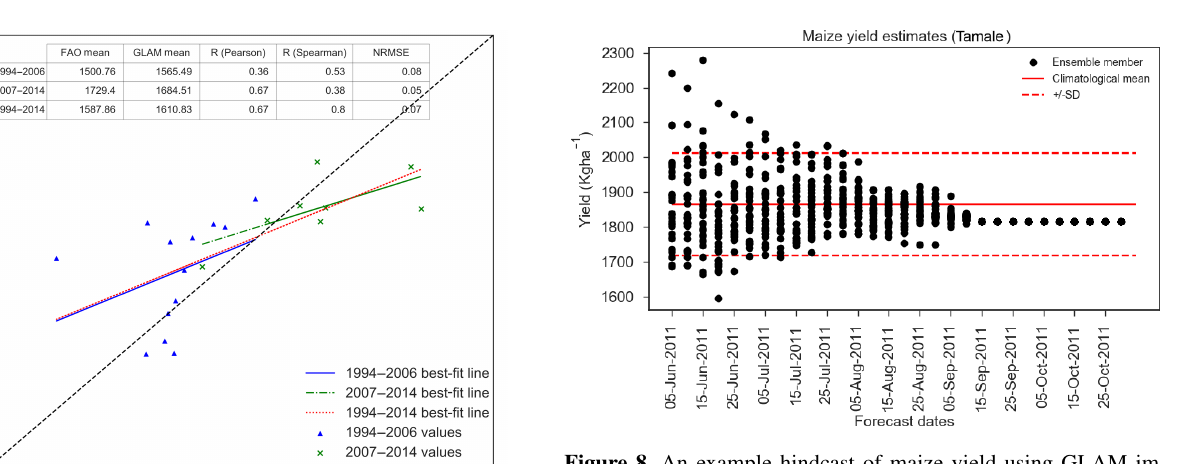
Figure 8. An example hindcast of maize yield using GLAM im- plemented into the TAMSAT-ALERT system. Black dots represent individual ensemble members and red lines are the